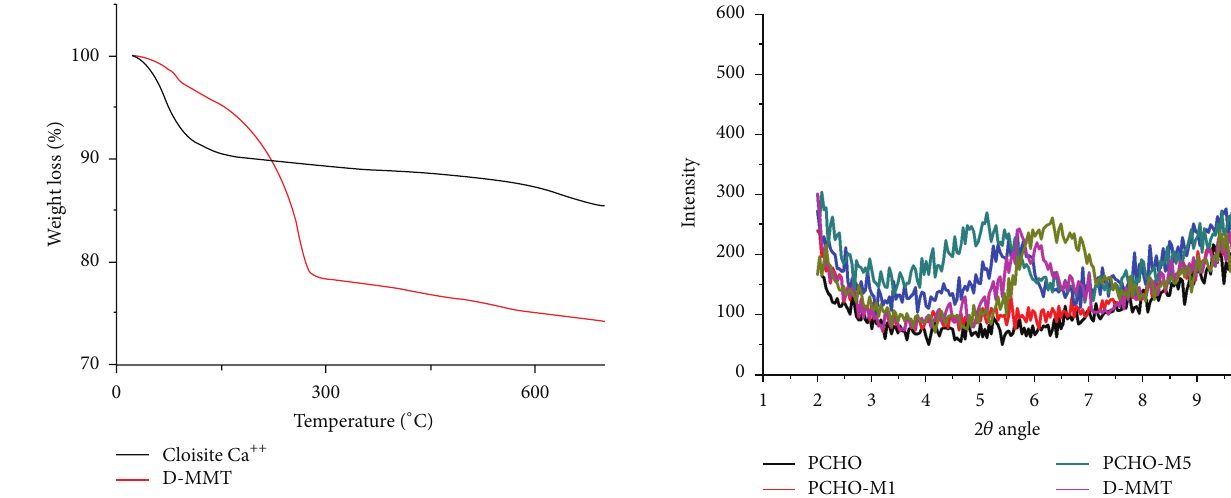
Figure 2: TGA diagram of Cloisite-Ca and D-MMT.